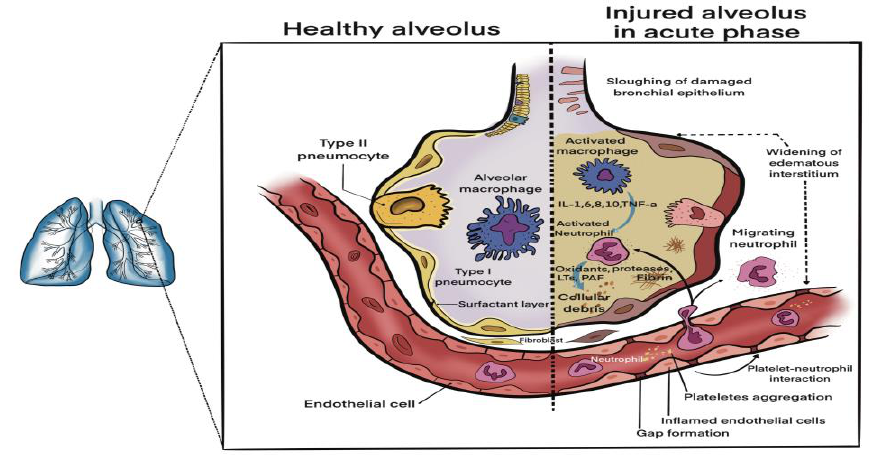
Figure 2. Biochemical changes in acute respiratory distress syndrome (ARDS)-damaged lung tissue.